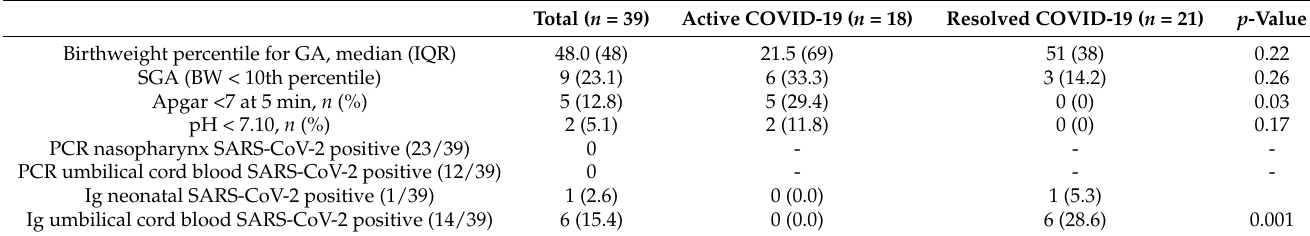
Table 2. Neonatal outcomes for the total study population and subgroups active COVID-19 and resolved COVID-19 at the time of giving